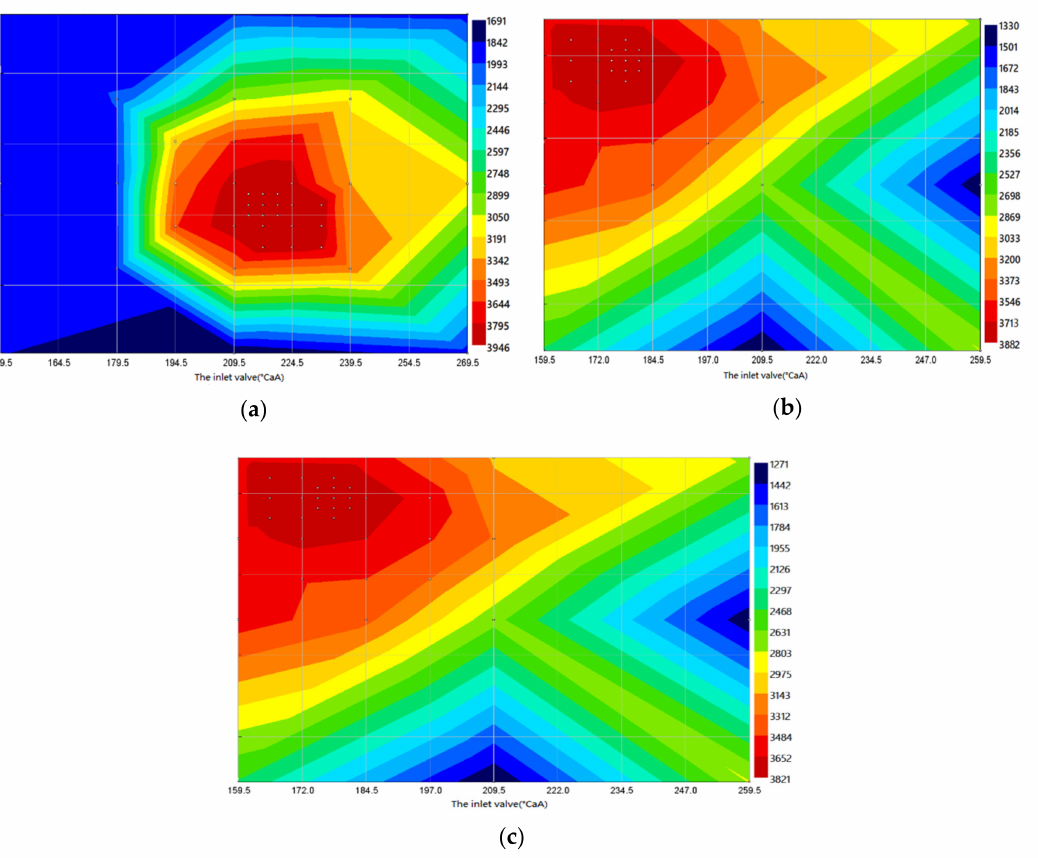
Figure 5. ( a ) B0, ( b ) B10, and ( c ) B20. Power of different biodiesel ratios under 75% load